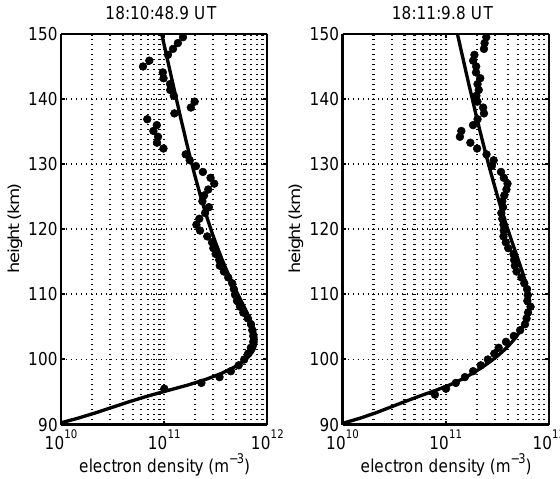
Fig. 3. Modelled electron density profiles (solid line) compared with smoothed electron density profiles (circles) measured by the EISCAT UHF radar.